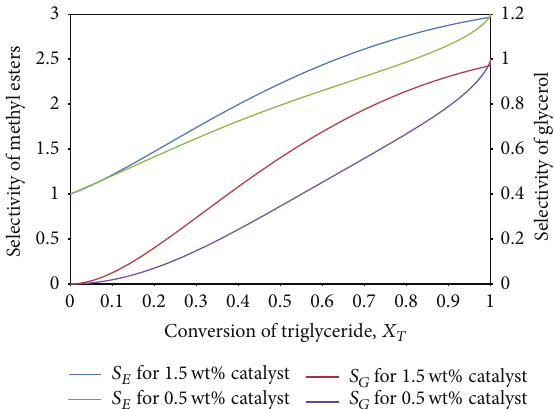
Figure 9: Selectivity of methyl ester at various catalyst concentra- tions, constant temperature of 30 ∘ C, and molar ratio 9 :1 for Case 2.